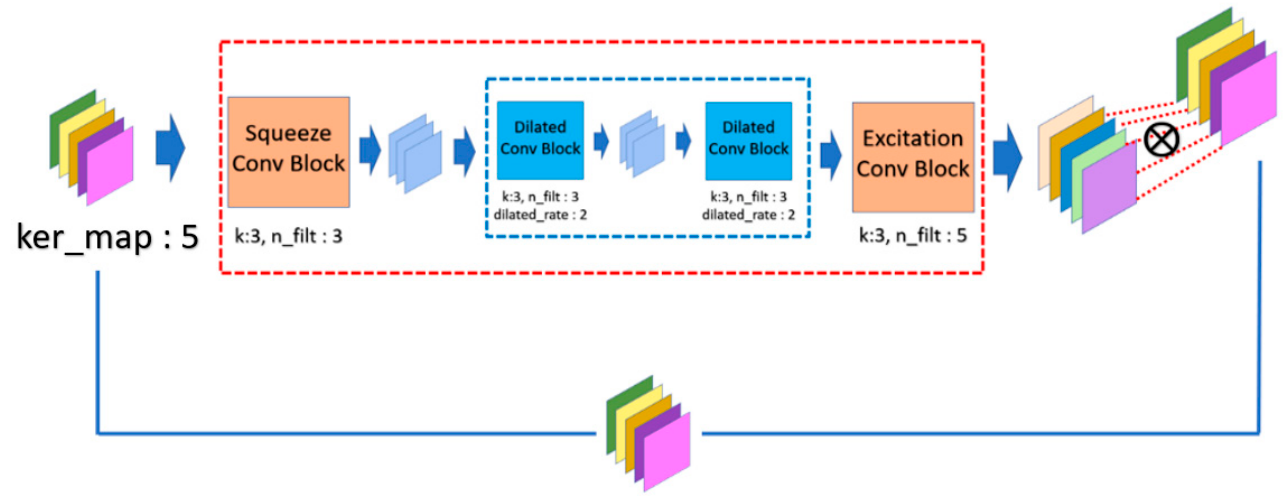
Figure 5. Operation mechanism architecture of spatial attention module